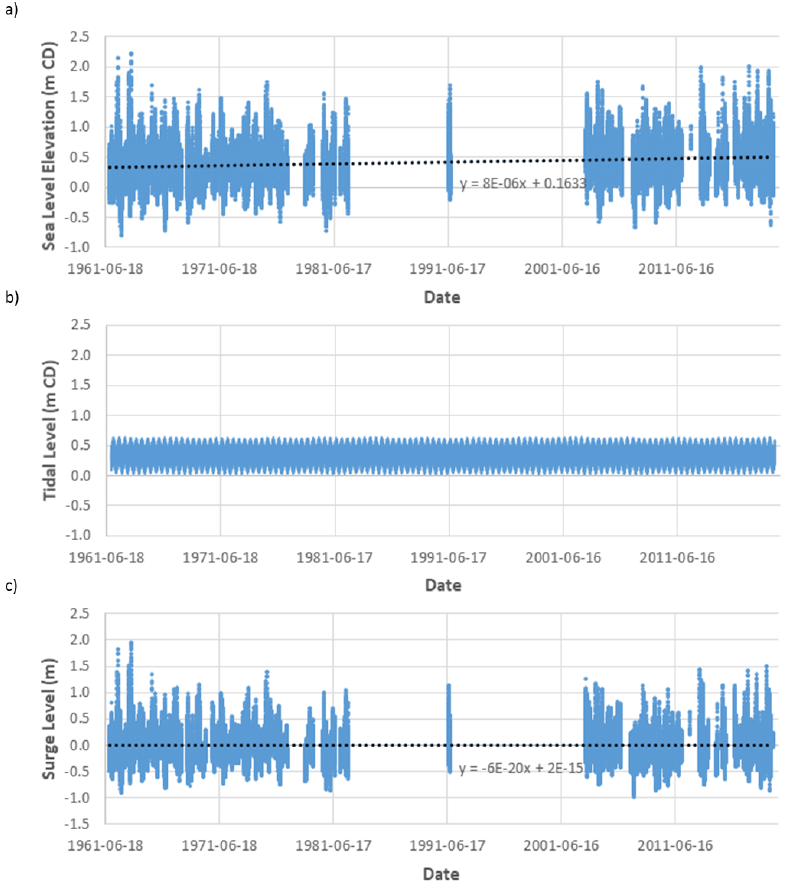
Figure 3. Station 6485, Tuktoyaktuk: ( a ) the measured water levels; ( b ) the predicted tides; ( c ) the water-level residuals.